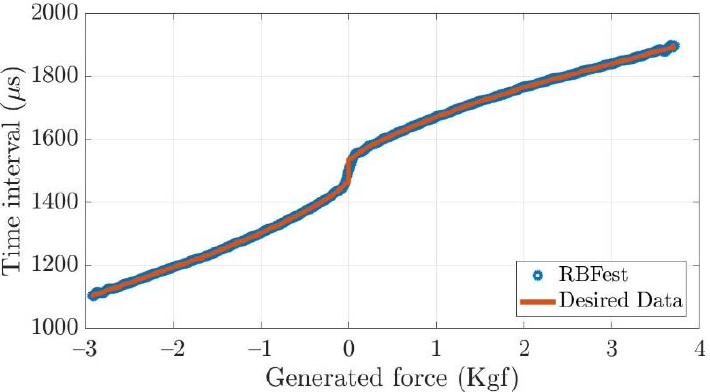
Figure 10. The generated force with respect to time interval (PWM) using radial basis function net- work approximation.